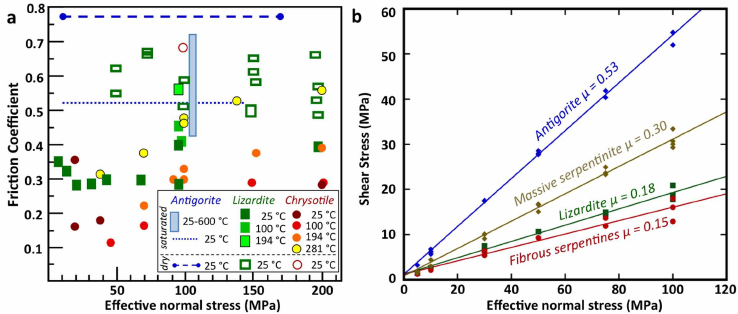
Figure 2. Summary of frictional strength of serpentine minerals. ( a ) Friction coefficient vs. effective normal stress for the three main varieties of serpentine minerals. Lizardite data (squares) have been compiled from [58] and references therein, and from [59]. Chrysotile data (circles) compiled from [60]. Antigorite data at room temperature represent the failure envelopes presented in Dengo et al. [61] and Tesei et al. [62] for dry precut cylinders (bold dashed line) and saturated fault gouges (thin dashed line), respectively. Friction of antigorite at variable temperature (light blue square) compiled from [63]. ( b ) Failure envelopes and friction coefficients of experimental serpentine fault gouges, modified from Tesei et al [62]. All tests were carried out at room temperature, saturated conditions and steady-state sliding velocity of 10 µ m/s, in a direct shear configuration. The slope of the linear fit represents the average coefficient of